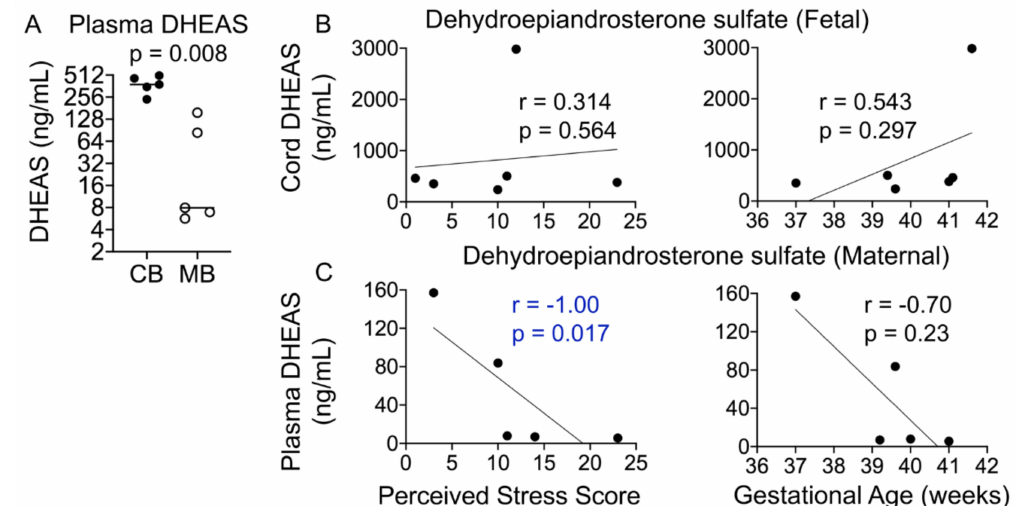
Figure 6. Maternal plasma DHEAS levels negatively correlate with the PSS. ( A ) Cord DHEAS levels were ~7-fold higher than maternal plasma DHEAS levels ( p = 0.008). ( B ) Cord DHEAS levels did not correlate significantly with the PSS or gestational age. ( C ) Maternal plasma DHEAS levels correlated negatively with the PSS ( p = 0.017) but not with gestational age. Mann–Whitney U test and Spearman’s correlation analysis.